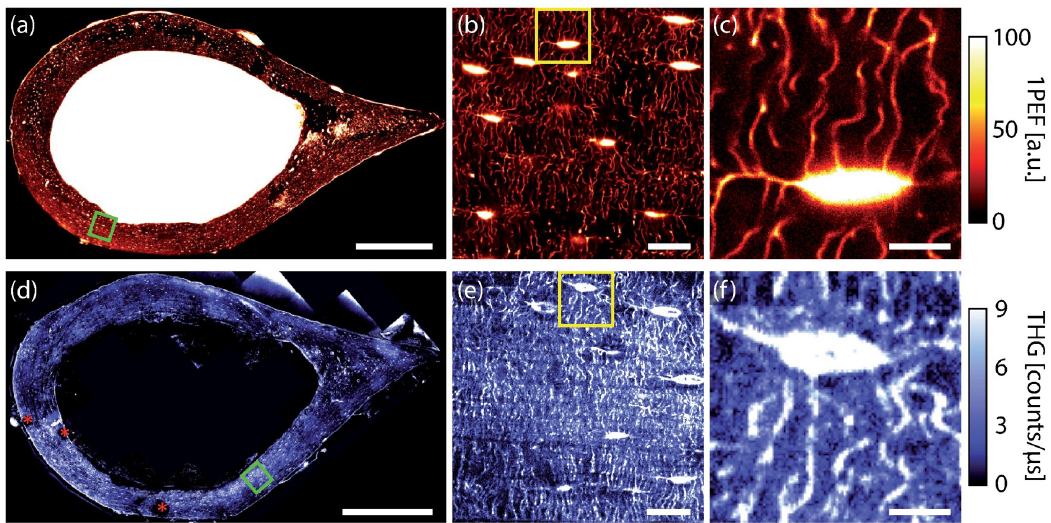
Fig 2. Comparison between confocal fluorescence microscopy (a,b,c) and THG imaging (d,e,f) of two different samples. (a,d) 2D composite images of full transverse cross-sections of a mouse femur. Regions shown in (b,e) are indicated by a green box in (a,d). Regions in (c,f) are indicated by a yellow box in (b,e). Red stars in (d) indicate the presence of air bubbles due to localized heating by absorption of the excitation light in the presence of polishing residues. Scale bar 500 μm (a,d), 20 μm (b,e) and 5 μm